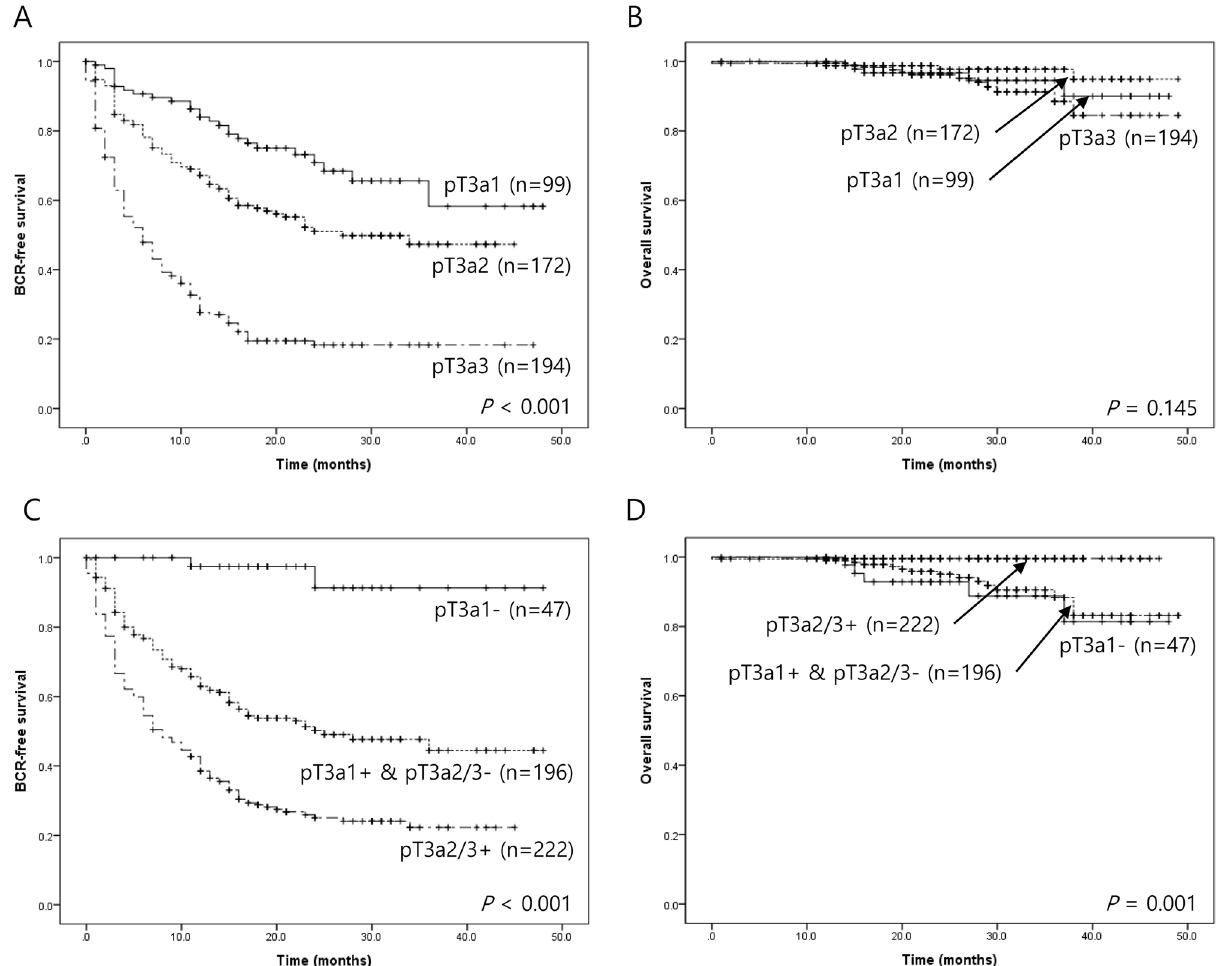
Figure 2. Kaplan-Meyer survival analysis according pT3a substage and the combination of pT3a substage and circumferential margin (CM) status. ( A ) The biochemical recurrence (BCR)-free survival was significantly different among pT3a subgroups ( P < 0.001). ( B ) No significant differences were identified in OS ( P = 0.145). ( C ) After the combination of pT3a substage and CM status, significant differences were identified among 3 subgroups ( P < 0.001). (D) pT3a2/3 + subgroup showed longer OS than other subgroups ( P =